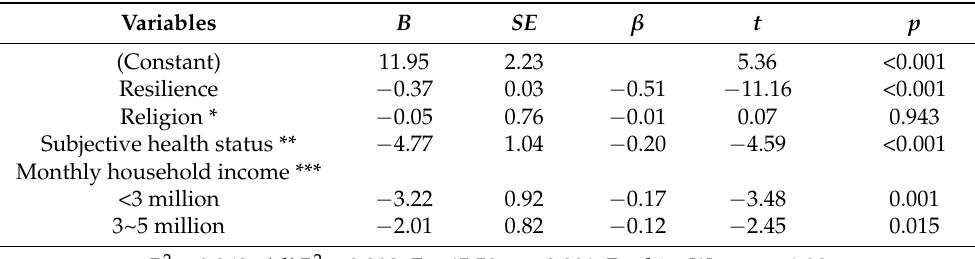
Table 4. Influencing factors of psychosocial